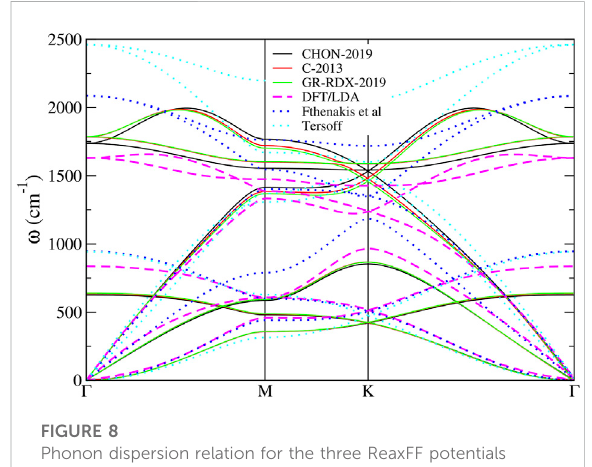
FIGURE 8 Phonon dispersion relation for the three ReaxFF potentials along Γ MK Γ path. FIGURE 9